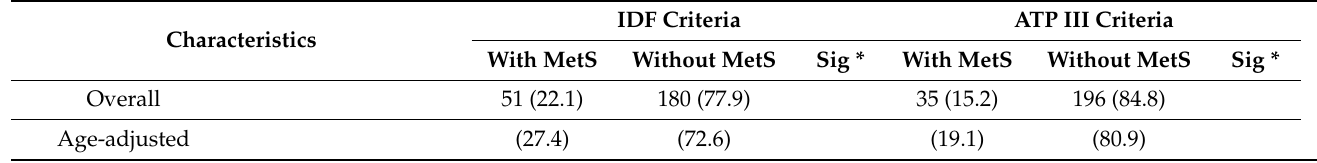
Table 2. Sample prevalence of MetS based on IDF and ATP III